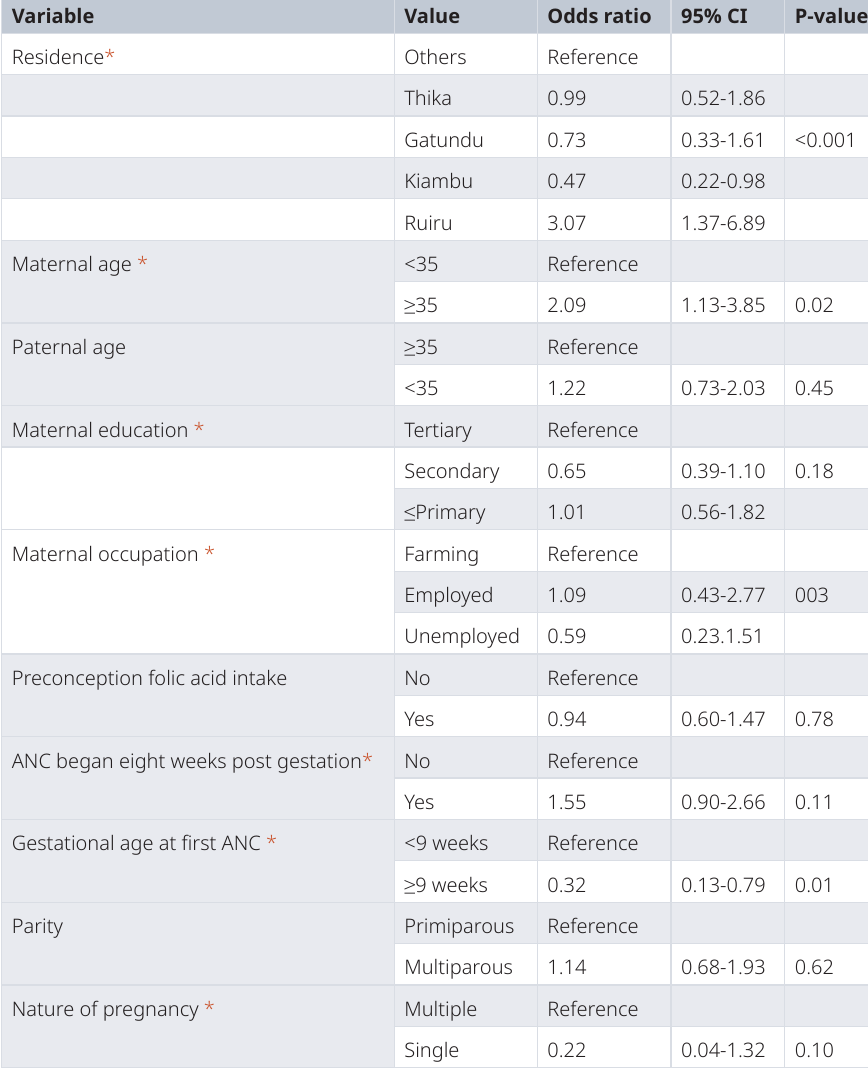
Table 4. Univariable analysis of factors associated with MESBDs among children in Kiambu County,